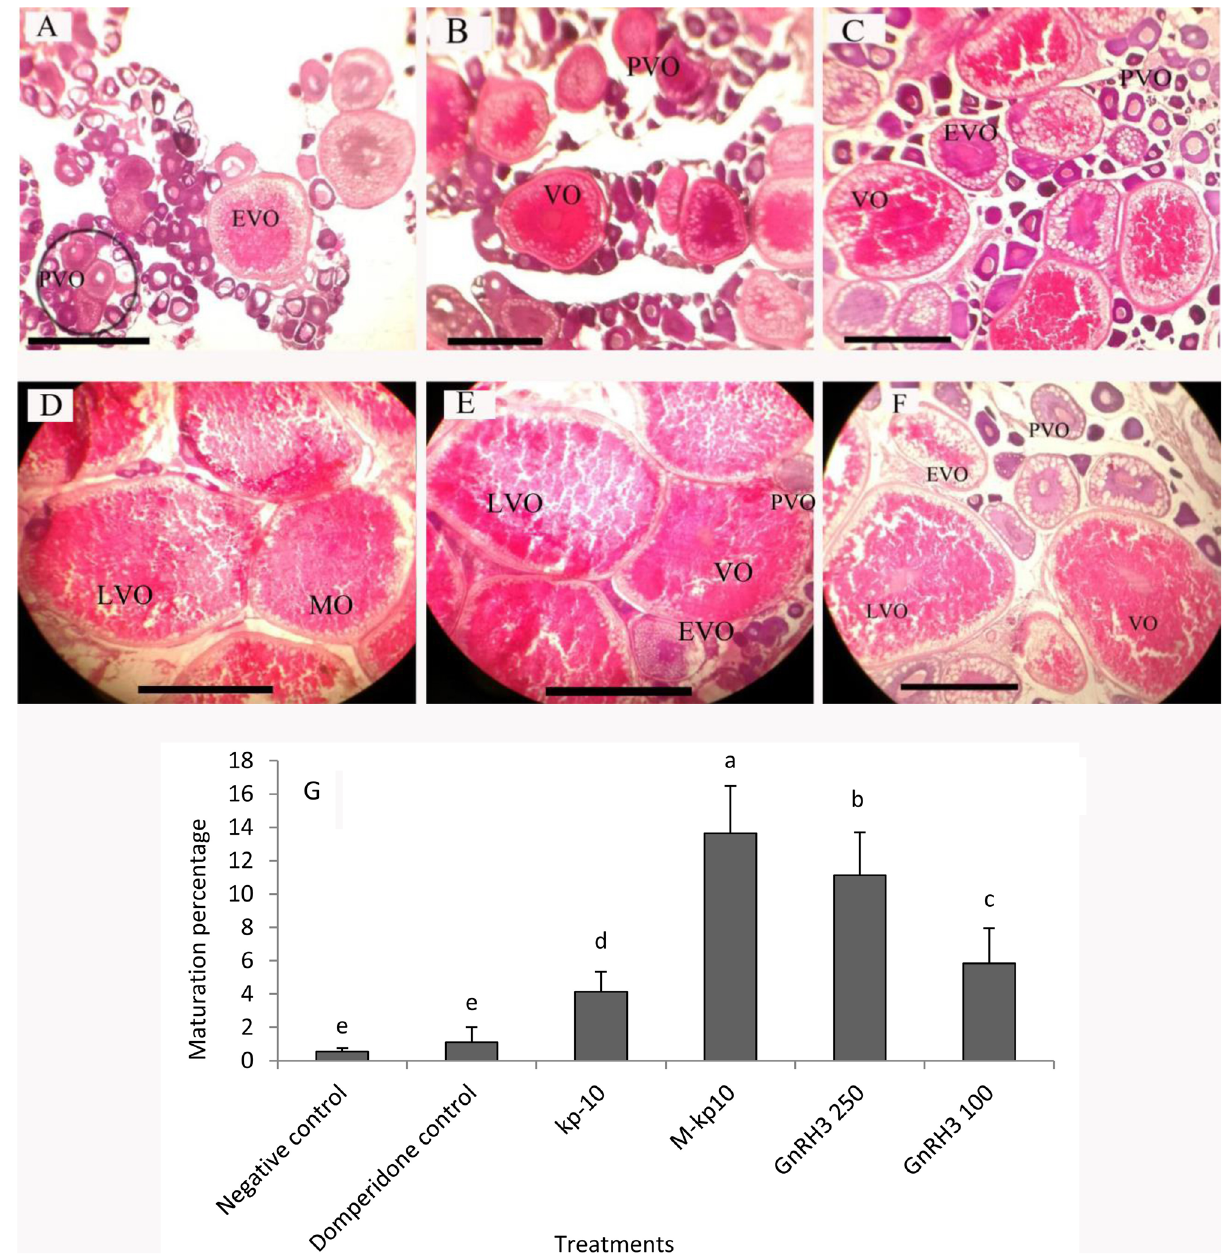
maturation percentage of oocytes ( G ). Abbreviations: PVO, pre-vitellogenic oocyte; EVO, early-vitellogenic oocyte; VO, vitellogenic oocyte; LVO, late-vitellogenic oocyte; PMO, pre-mature oocyte; MO, mature oocyte. Scale bar = 500